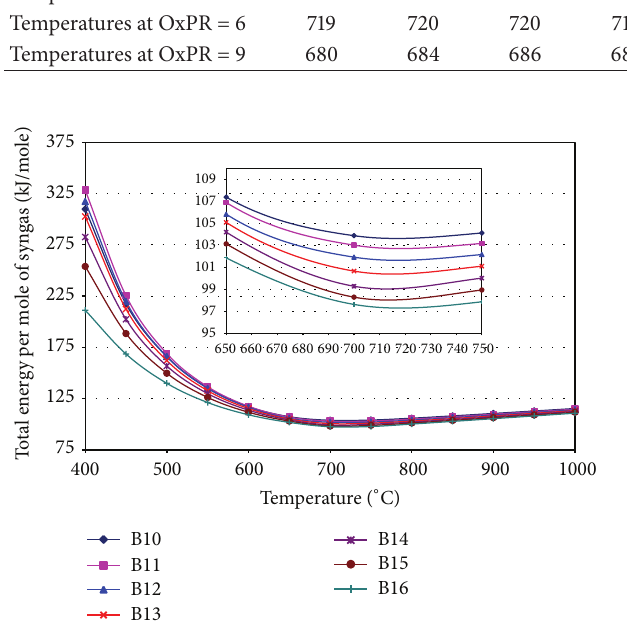
Figure 4: Total energy per mole of syngas in CR of propane.